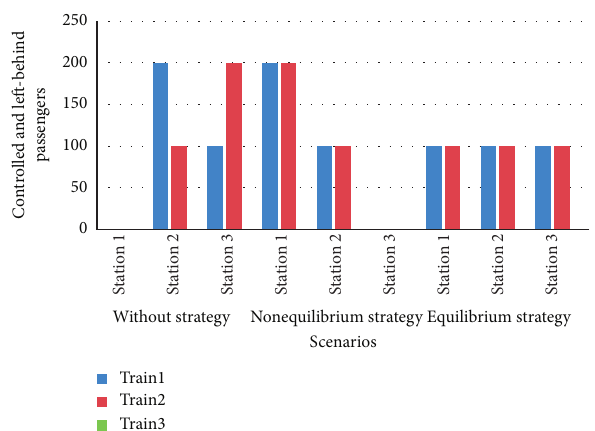
Figure 18: The comparison of controlled and left-behind pas- sengers in different